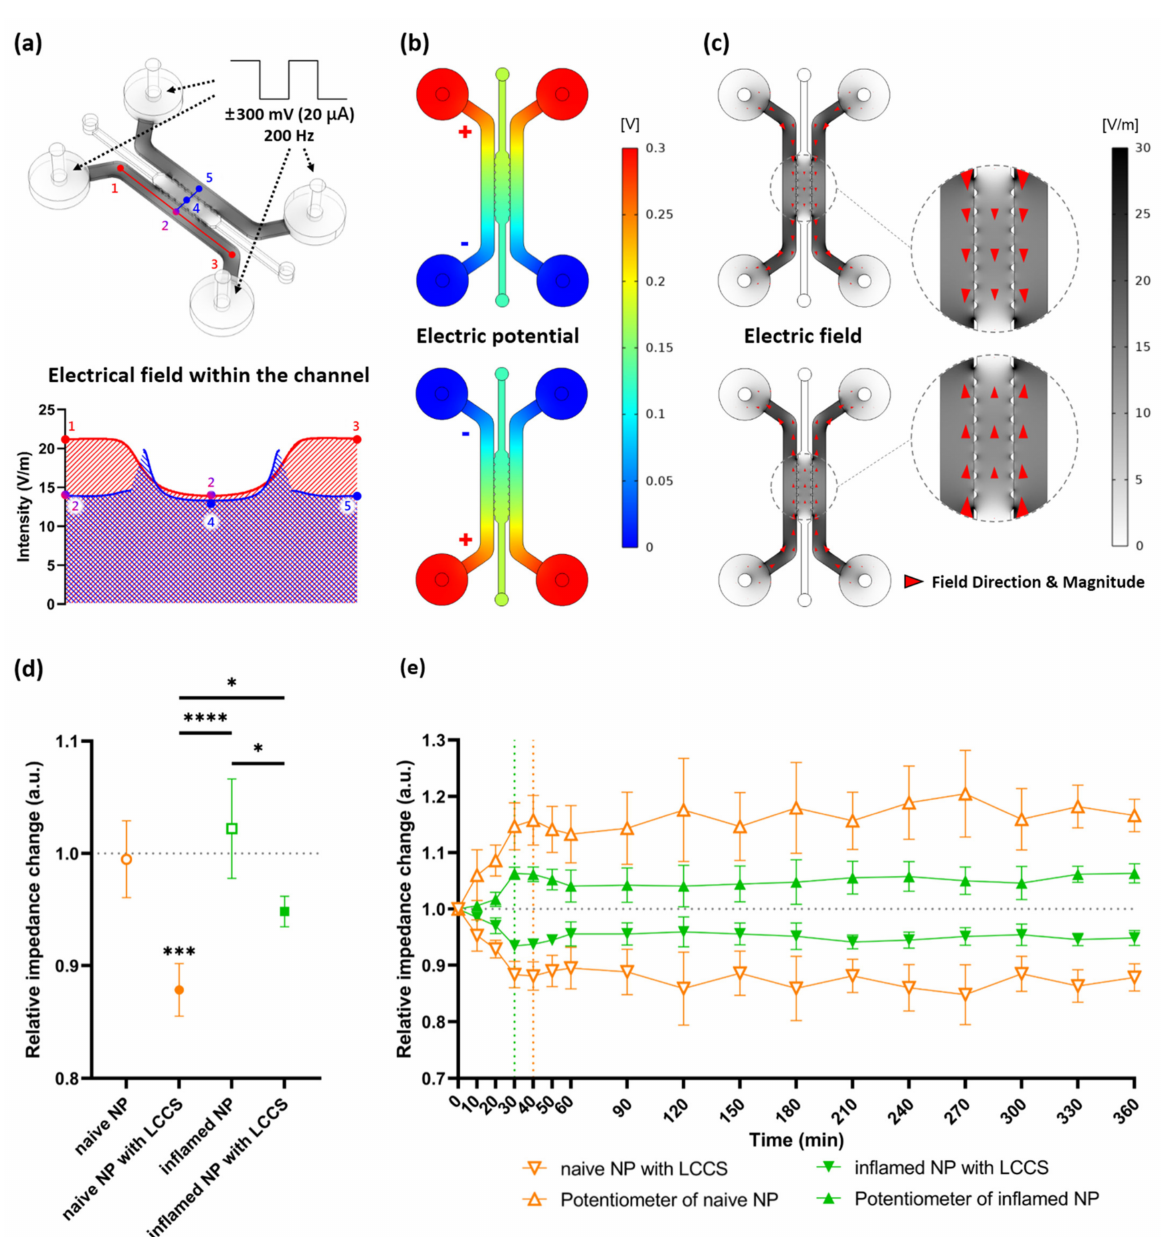
Figure 3. Simulation by applying a biphasic signal to the internal channels and the experimental results of relative impedance change on human NP cells exposed to IL-1 β applied at LCCS. ( a ) The electric field within the channels was applied at the biphasic signals ( ± 300 mV, 20 µ A, 200 Hz). Each numbered point denotes the electric field intensity. ( b ) Formation of electric potential differences due to polarity (positive and negative) changes of electrodes. ( c ) Changes in electric field direction (red arrowhead) by the different electric potentials. ( d ) Relative impedance changes in the medium from naïve NP or inflamed NP with/without LCCS, and 1.0 denotes the initial impedance (at 0 min), and the relative impedance change was measured after 6 h (360 min) from the initial impedance. ( e ) Relative impedance changes for each group in a time-dependent manner. Each value is the mean ± standard error of four or five independent experiments. *** p < 0.001, as compared with naïve NP. * p < 0.05, **** p < 0.0001, the line indicates comparison with each